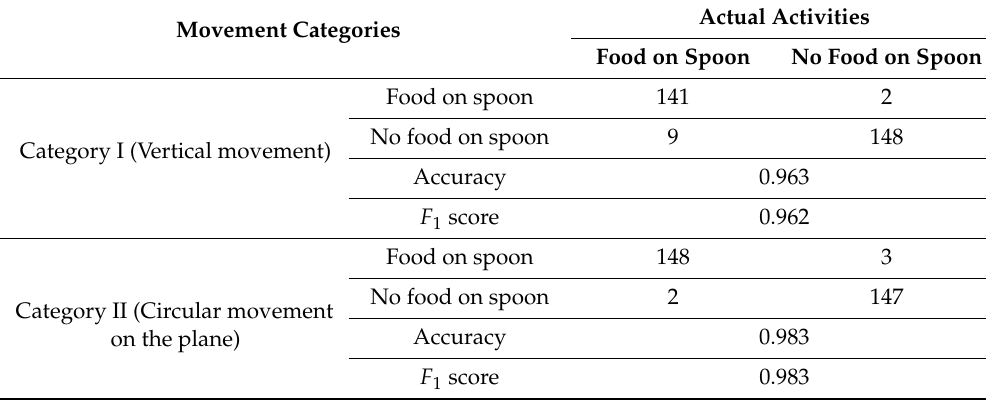
Table 1. Confusion matrix for accuracy and F 1 score analysis of food